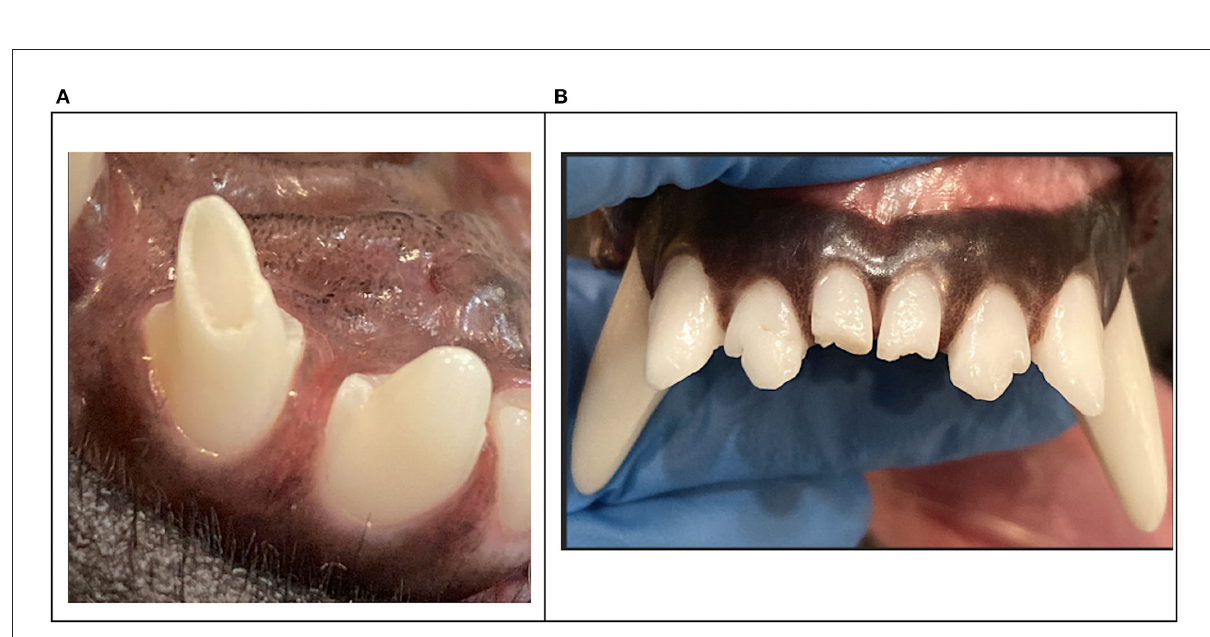
FIGURE9 Clinical photographs demonstrating an enamel-dentin fracture on the maxillary third incisor (A) and enamel-dentin fracture on the right and left mandibular first incisors (B)